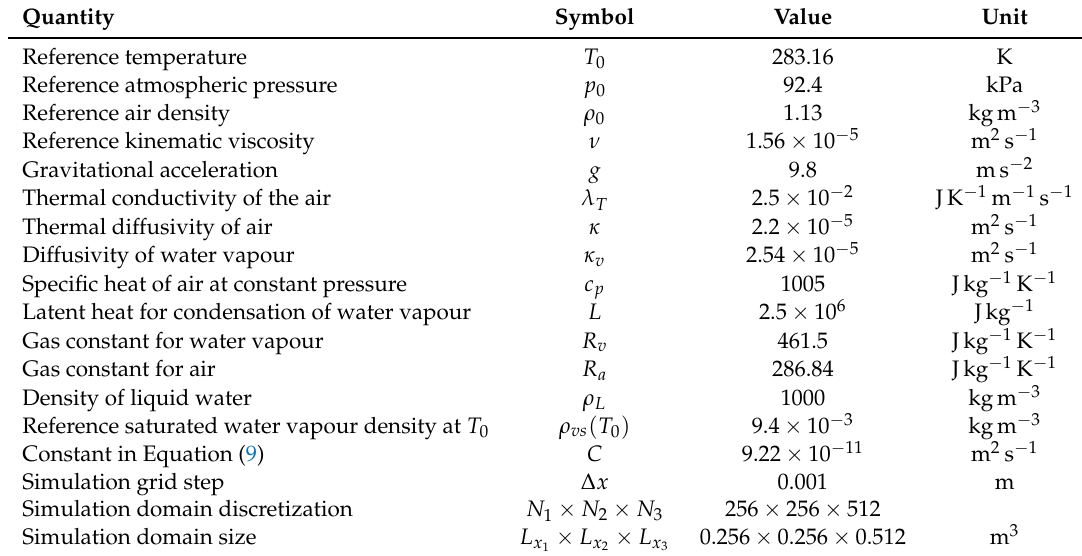
Table 1. Simulation parameters, constants and domain specifications used for simulation